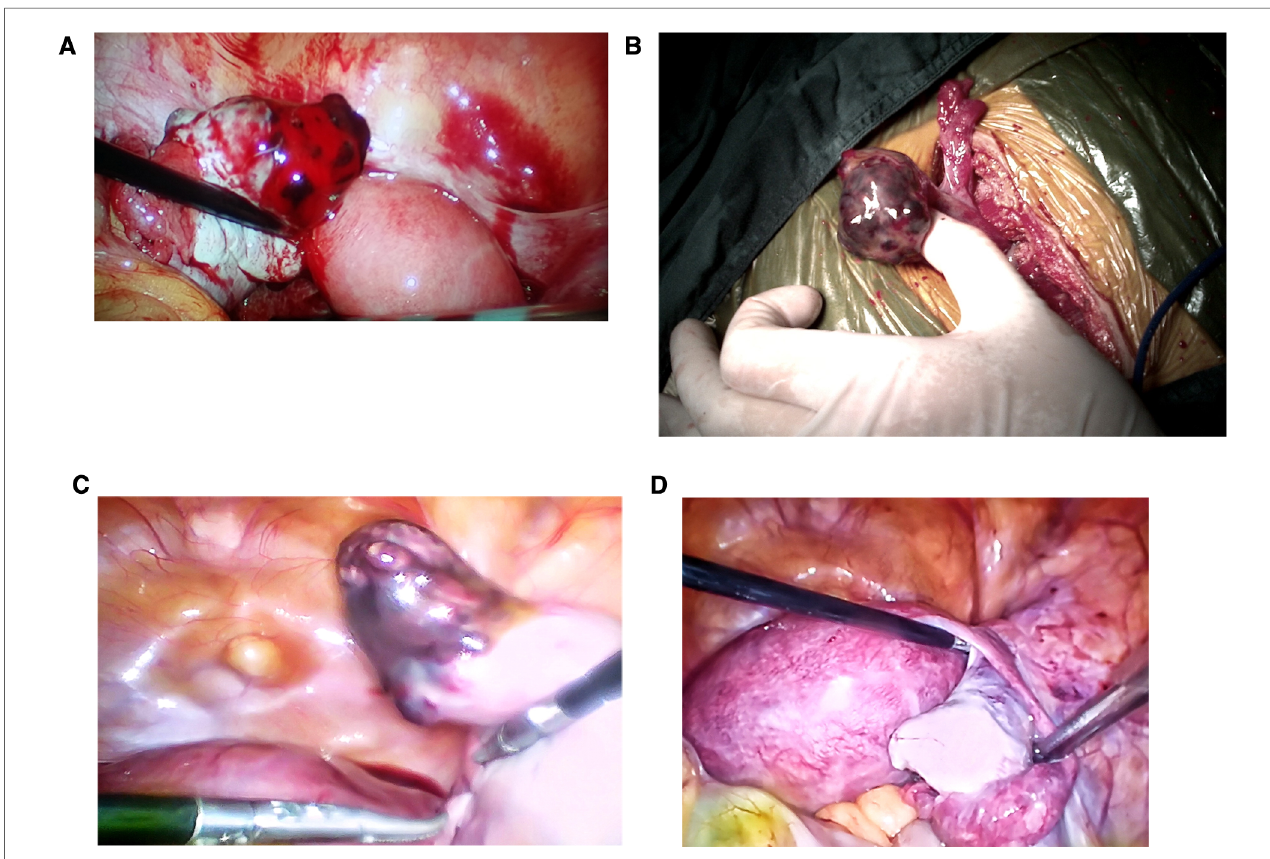
FIGURE 3 Intraoperative photographs of ovarian pregnancy patients: ( A ) laparoscopic image of a ruptured ovarian pregnancy lesion. ( B ) Image of an unruptured ovarian pregnancy through laparotomy. ( C ) and ( D ) show the graph in the same patient. ( C ) Laparoscopic image of an ovarian pregnancy lesion. ( D ) The reconstructed ovary tissue after pregnancy